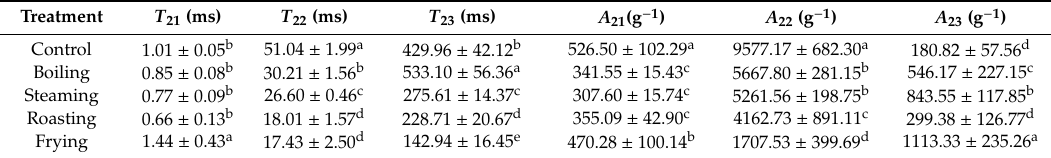
Table 1. 1 H low-field nuclear magnetic resonance (LF-NMR) parameters of T 2 relaxation times and peak areas ( A ) of Spanish mackerel before (control) and after boiling, steaming, roasting and